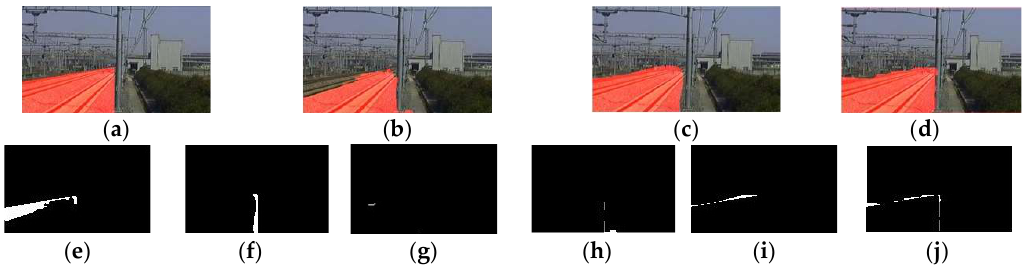
Figure 15. Missing and extra areas of different methods comparing with the ground truth. ( a ) Manual label of track areas. ( b ) Results of the MCG. ( c ) Results of the FCN. ( d ) Results of our method. ( e ) Missing part of MCG. ( f ) Missing part of FCN. ( g ) Missing part of our method. ( h ) Extra part of MCG. ( i ) Extra part of FCN. ( j ) Extra part of our method.